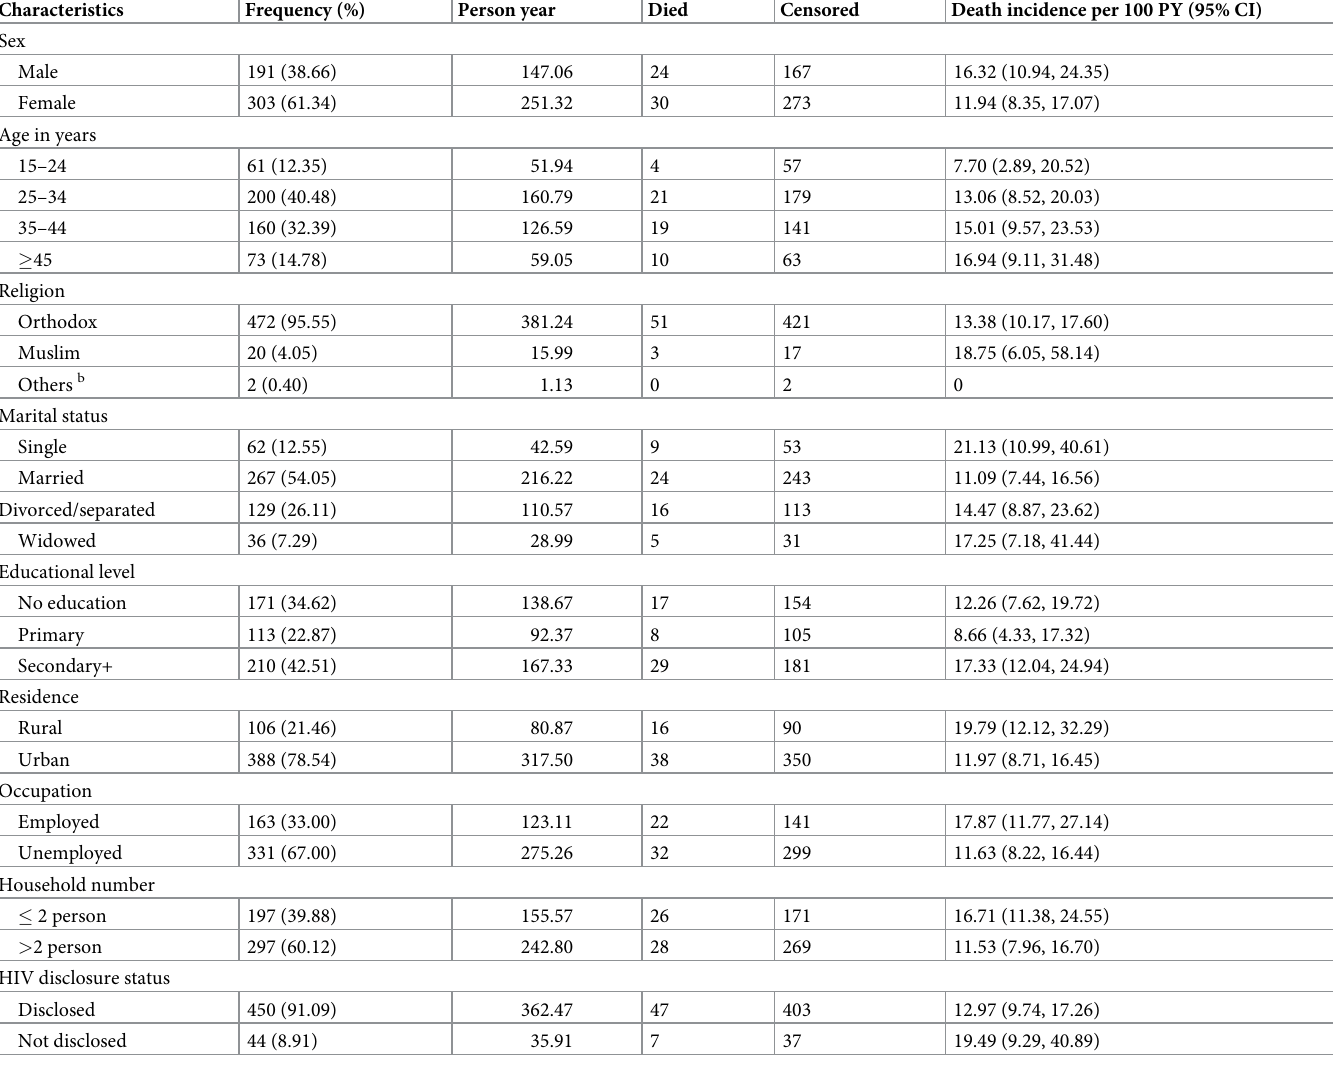
Table 1. Mortality rate within one year follow-up period stratified by socio-demographic characteristics of adults on ART at Debre-Markos Referral Hospital from January 1, 2014 to December 31, 2018 (n = 494).